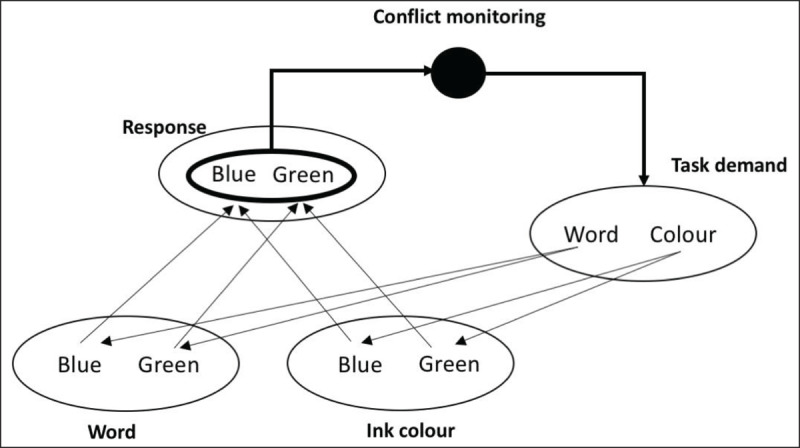
Schematic representation of the conflict monitoring theory.In a Stroop task, the ink colour and the word activate their corresponding response. In case of incongruent trials, competition is detected between the responses activated by the task-relevant and by the task- irrelevant dimension. As a result, attention on the task-relevant dimension is increased on the next trial. (adapted from Botvinick, Braver, Barch, Carter & Cohen, 2001).